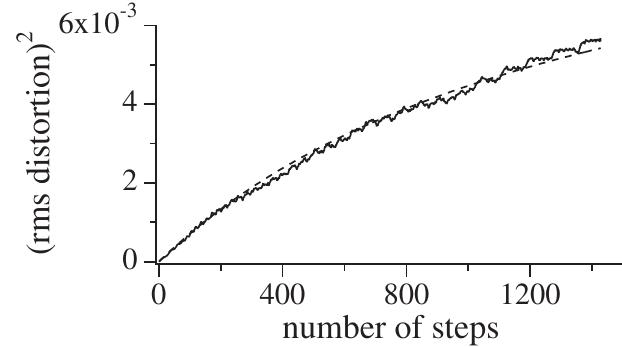
FIG. 15. Evolution of the square of rms optics distortion. There are 1428 ( (cid:2) 84 cells (cid:5) 17 turns) steps. The solid curve is simulation results and the dashed curve is the random walk model.